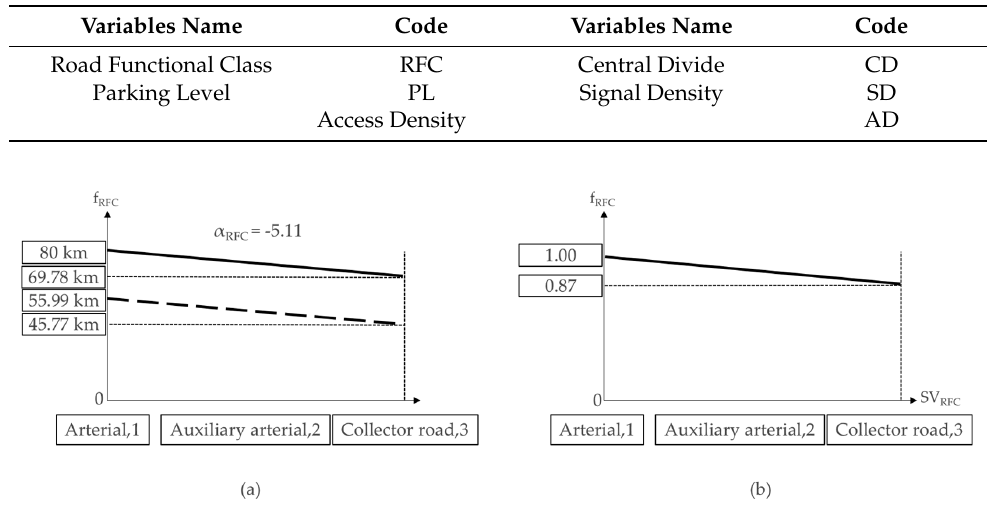
Table 11. Variable abbreviations.